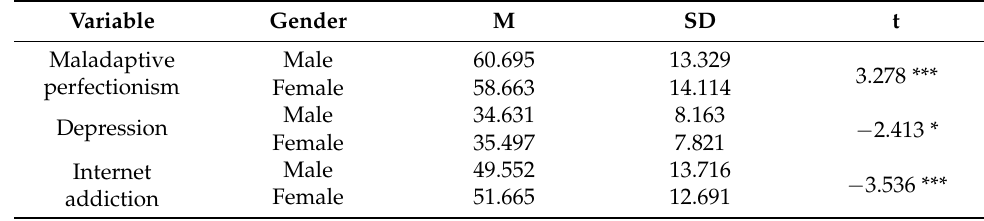
Table 3. Description and comparison of key variables by gender.